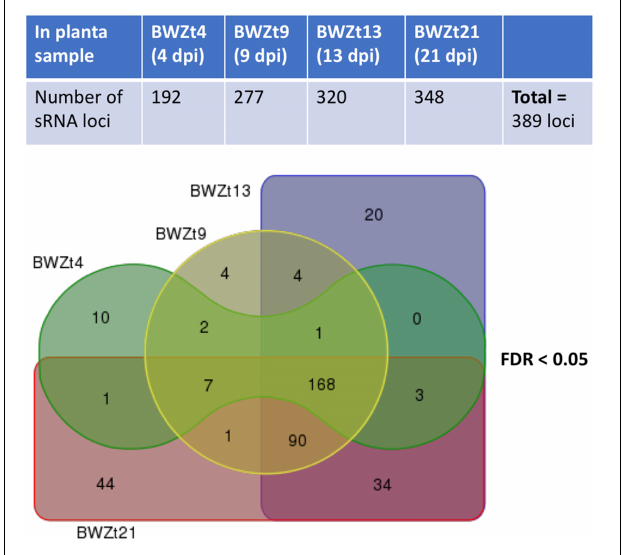
FIGURE 1 | Predicted Zymoseptoria tritici sRNA loci active during different timepoints of wheat infection. Numbers of sRNA loci upregulated at 4, 9, 13, and 21 days post-inoculation (dpi) of a susceptible wheat cv. Bobwhite with Z. tritici isolate IPO323 are shown in the upper panel. A Venn diagram showing numbers of infection stage-specific sRNA loci as well as those shared between the consecutive infection timepoints is presented in the lower panel. False discovery rate (FDR) rate for differential sRNA loci expression in at least one comparison between the infected wheat samples and the corresponding mock samples was set to <